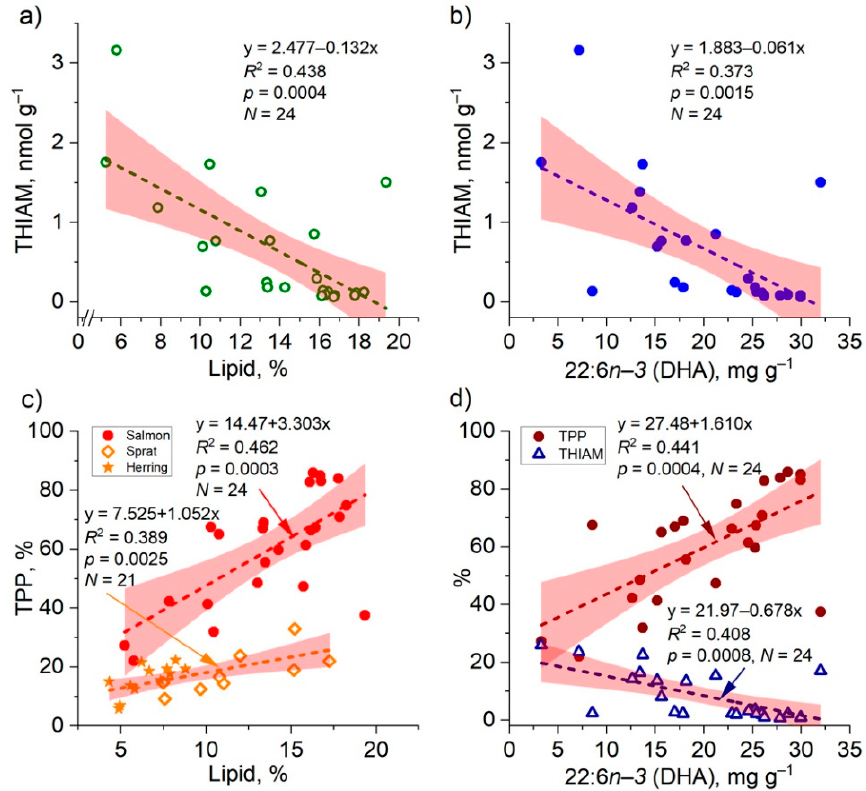
Figure 7. The relationship of the concentration of muscle free thiamine (THIAM) of salmon ( Salmo salar ) with ( a ) total lipid content and ( b ) docosahexaenoic acid (22:6 n − 3 , DHA) concentration, ( c ) relationship of the proportion of thiamine pyrophosphate (TPP) in salmon muscle and in the whole body of sprat ( Sprattus sprattus ) and herring ( Clupea harengus ) with total body lipid content, and ( d ) relationship of the proportions of muscle TPP and THIAM with the DHA concentration of salmon. Salmon, sprat, and herring were from the Baltic Proper, Bothnian Sea, and Gulf of Finland. The fitting of the linear models with 95% confidence bands, coefficients of determination ( R 2 ), significances ( p ) of the model, and the number of samples are given. Table 4. Pearson correlations of hepatic glucose 6-phosphate dehydrogenase activity (G6PDH, µ mol min − 1 mg prot − 1 ) and malondialdehyde (MDA, µ mol g − 1 ) and total thiamine (TotTh, nmol g − 1 ) concentrations with whole-body lipid content (%) and the concentrations (i.e., lipid- weighed proportions, mg g − 1 ) of the fatty acid classes of salmon ( Salmo salar ) caught in the Baltic Proper, the Bothnian Sea, and the Gulf of Finland in the late fall.